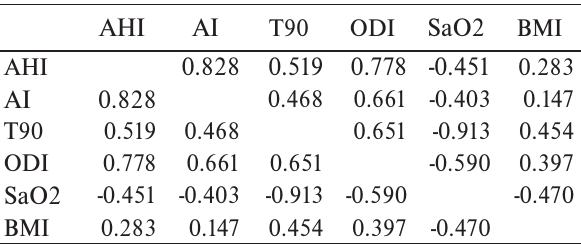
Table 1. Mutual correlations between the monitored vari- ables. Spearman’s correlation coefficients are shown; all reported correlations were statistically